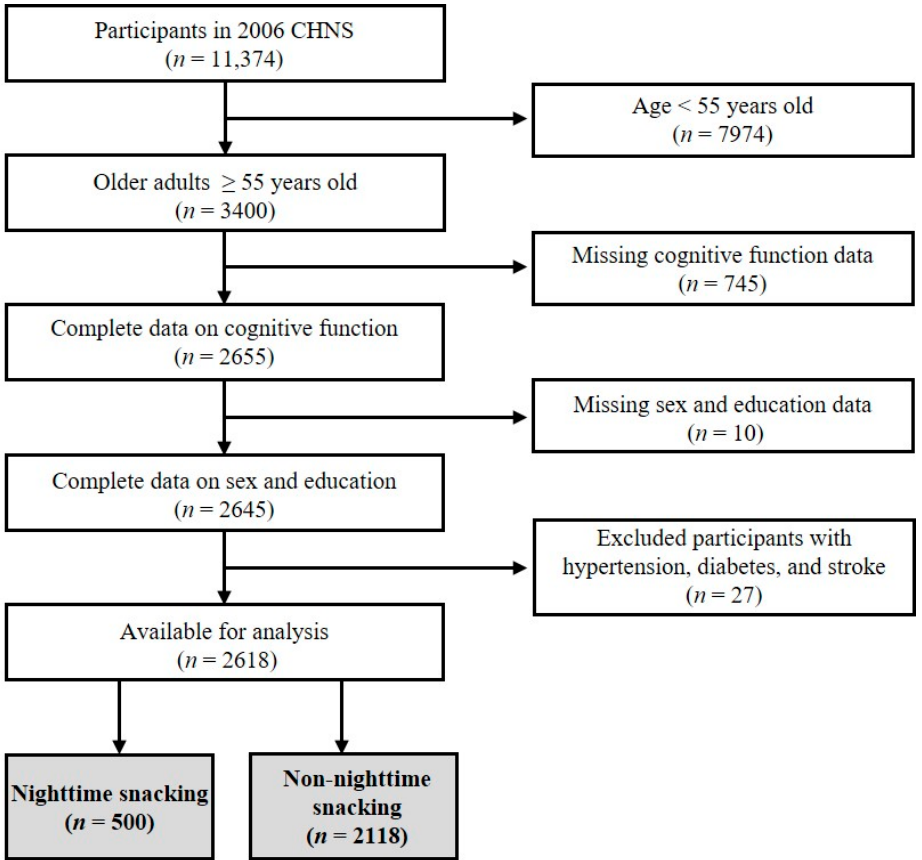
Figure 1. The flow chart of participant selection.